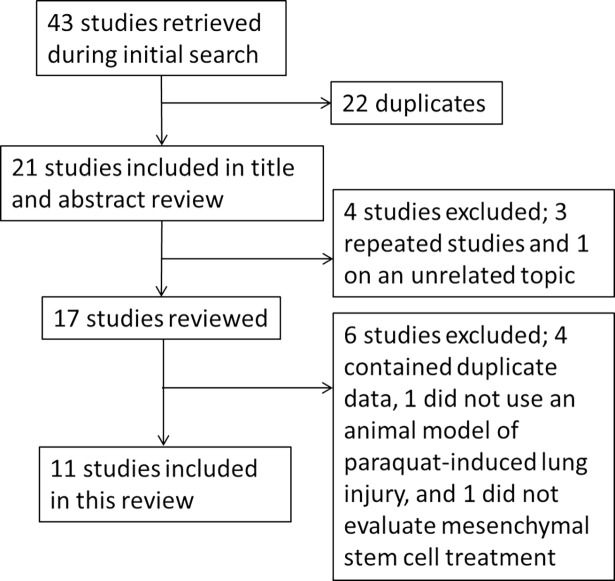
Included and excluded studies.